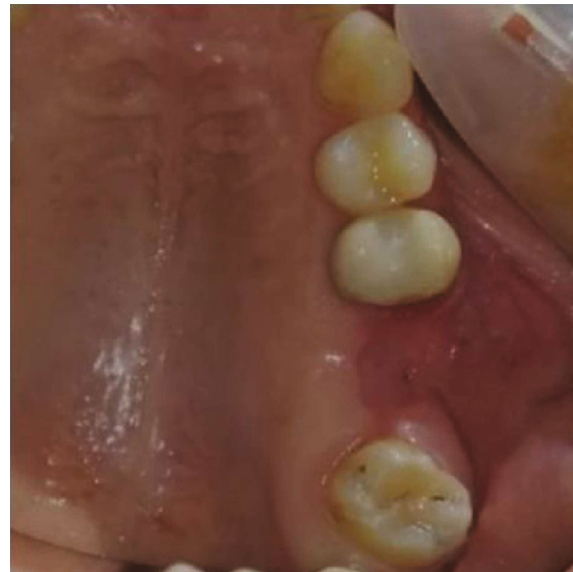
Figure 9: Intraoral view showing healing at 40